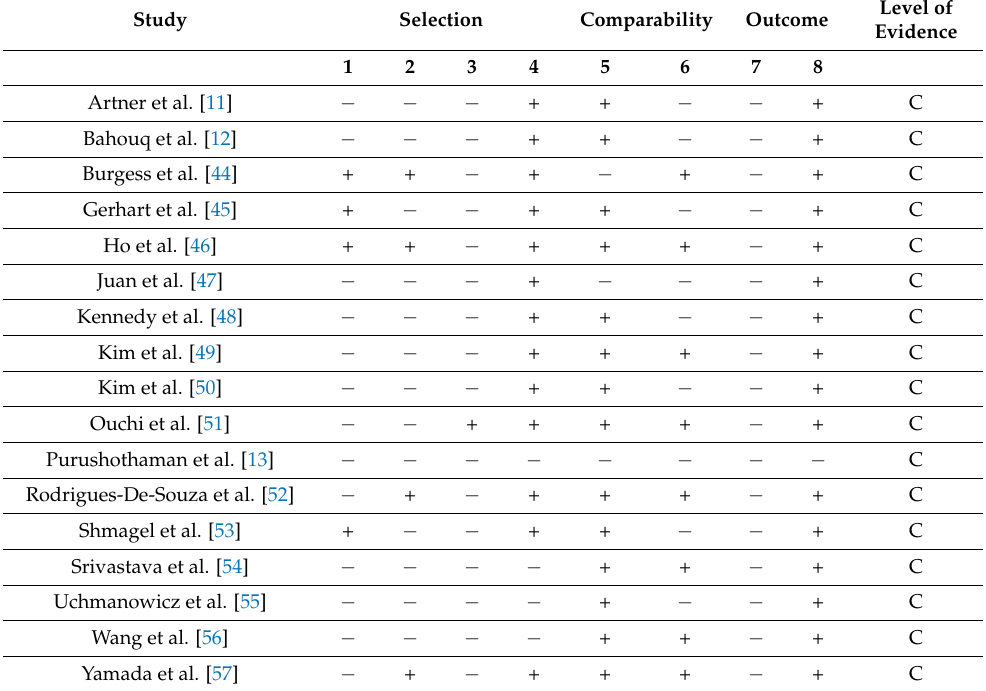
Table 4. Methodological quality of cross-sectional